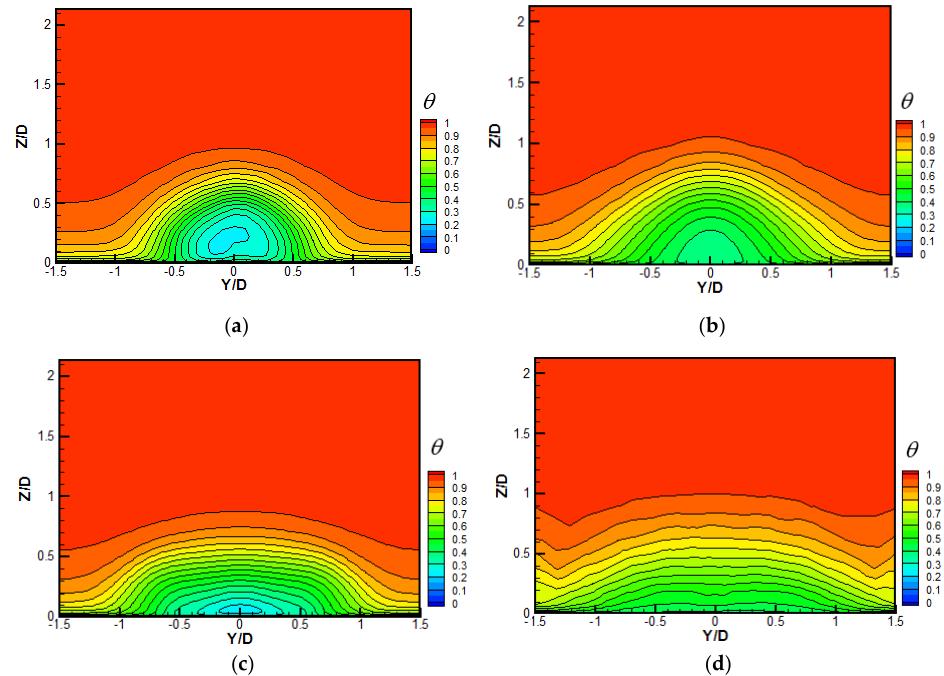
Figure 6. Contours of non-dimensional temperature over the surface X/D = 5 at M = 0.5. ( a ) CYL; ( b ) CIR_CRA; ( c ) CRA1; ( d ) CRA2. When the blowing ratio increases to M = 1.5, the streamline and non-dimensional temperature distributions over the surface X / D = 5 are depicted in Figures 7 and 8, respec- tively. It is seen that the scale of the kidney-shaped vortex pair for the CYL hole is signif- icantly enlarged, induced by the higher coolant momentum. For the CIR_CRA and CRA1 holes, attributed to the limited effect of the shallow crater, the kidney-shaped vortex pairs are influenced slightly with similar scales to that for the CYL hole. For the CRA2 hole, the deeper crater provides an anti-kidney-shaped vortex pair with strong intensity to over- come the original kidney-shaped vortex pair. Hence, the anti-kidney-shaped vortex pair dominates the flow structure at plane X / D = 5 for the CRA2 hole at M = 1.5. The non- dimensional temperature contours at M = 1.5 show similar bump-like shapes for the CYL, CIR_CRA, and CRA1 holes, i.e., the lowest temperature occurs around the hole centerline, and the temperature gradually rises along the lateral direction, and the coolant core is lifted off away from the wall surface. However, the CRA2 hole exhibits a dramatically different temperature contour at plane X / D = 5 from the other three holes. More coolants are allocated sideways due to the wider crater exit area of the CRA2 hole, and fewer cool- ants are concentrated near the hole centerline. The more important is that the coolants ejected from the CRA2 hole are attached to the wall surface, and the temperature is sig- nificantly reduced, especially sideways. ( a ) ( b )